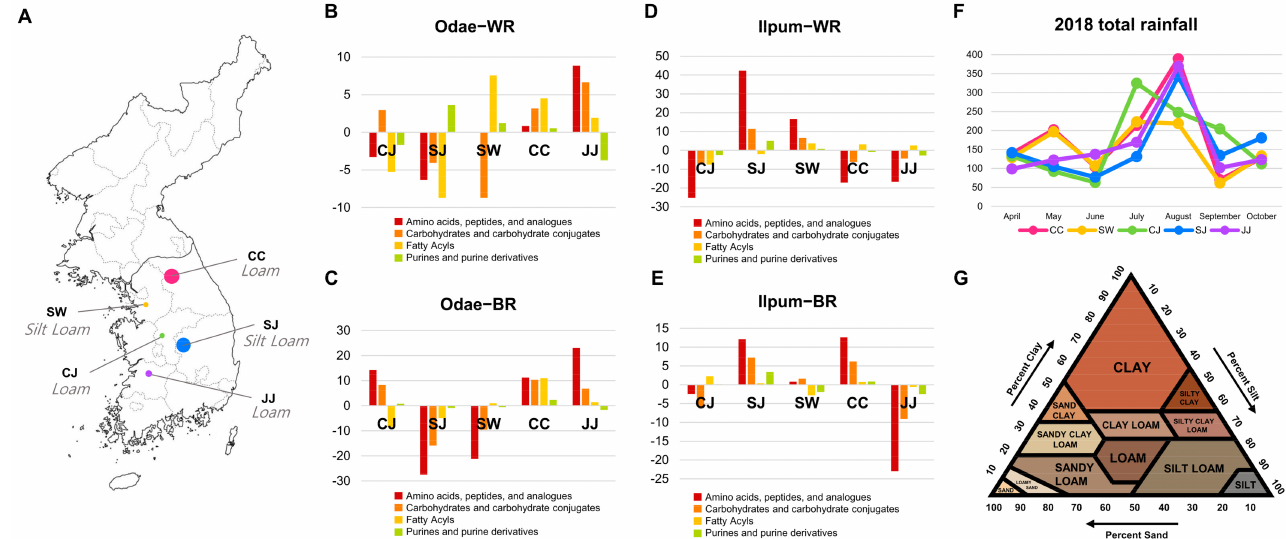
Figure 5. The metabolic signatures with regional specificity. The metabolites were classified into 4 major classes and normal- ized by autoscaling. The y -axis is the sum of the normalized intensities of the metabolites in each class. ( A ) Geographic map of the cultivation regions in Korea. The relative abundances of 4 chemical classes in white rice and ( B ) brown rice ( C ) of the Odae cultivar and white rice and ( D ) brown rice ( E ) of the Ilpum cultivar. ( F ) Total rainfall (from April to October 2018) and ( G ) soil texture of 5 different cultivation regions. Information on the soil texture was acquired from the National Institute of Agricultural Sciences (http://soil.rda.go.kr/soil/index.jsp) (accessed on 20 June 2020), and the triangle chart is presented based on information from the United States Department of Agriculture (USDA). CJ: Cheongju (Chungcheongbuk − do), SJ: Sangju (Gyeongsangbuk − do), SW: Suwon (Gyeonggi − do), CC: Cuncheon (Gangwon − do), JJ: Jeonju (Jeollabuk −